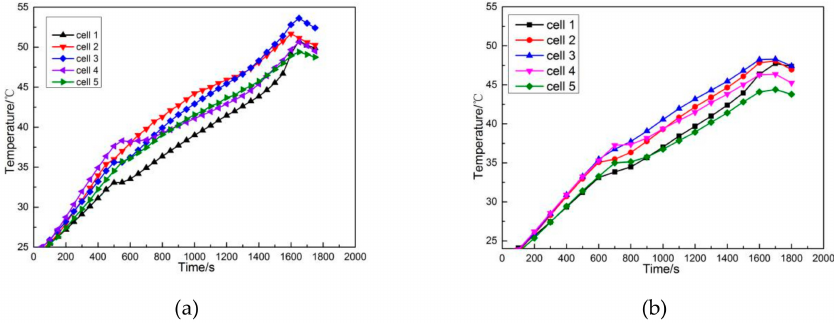
Figure 12. Surface temperature curve at 2C discharge rate under thermal management of di ff erent EG content CPCM combined with thermoelectric refrigeration sheets: ( a ) 15% EG; ( b ) 20%